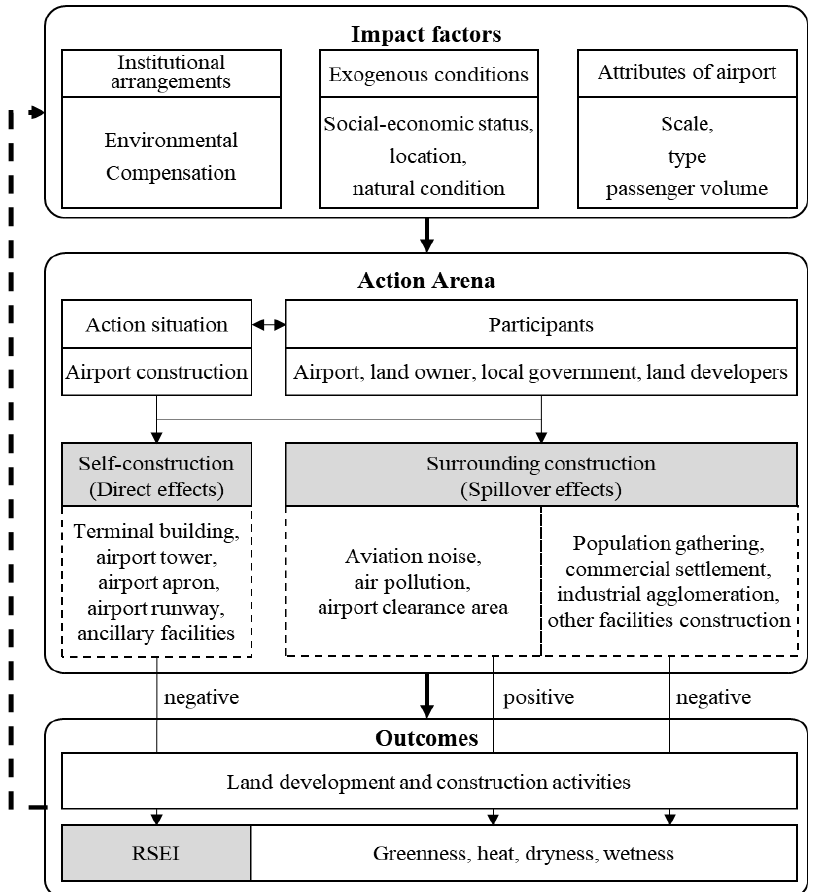
Figure 1. IAD framework of the impacts of airports on surrounding ecological environments.